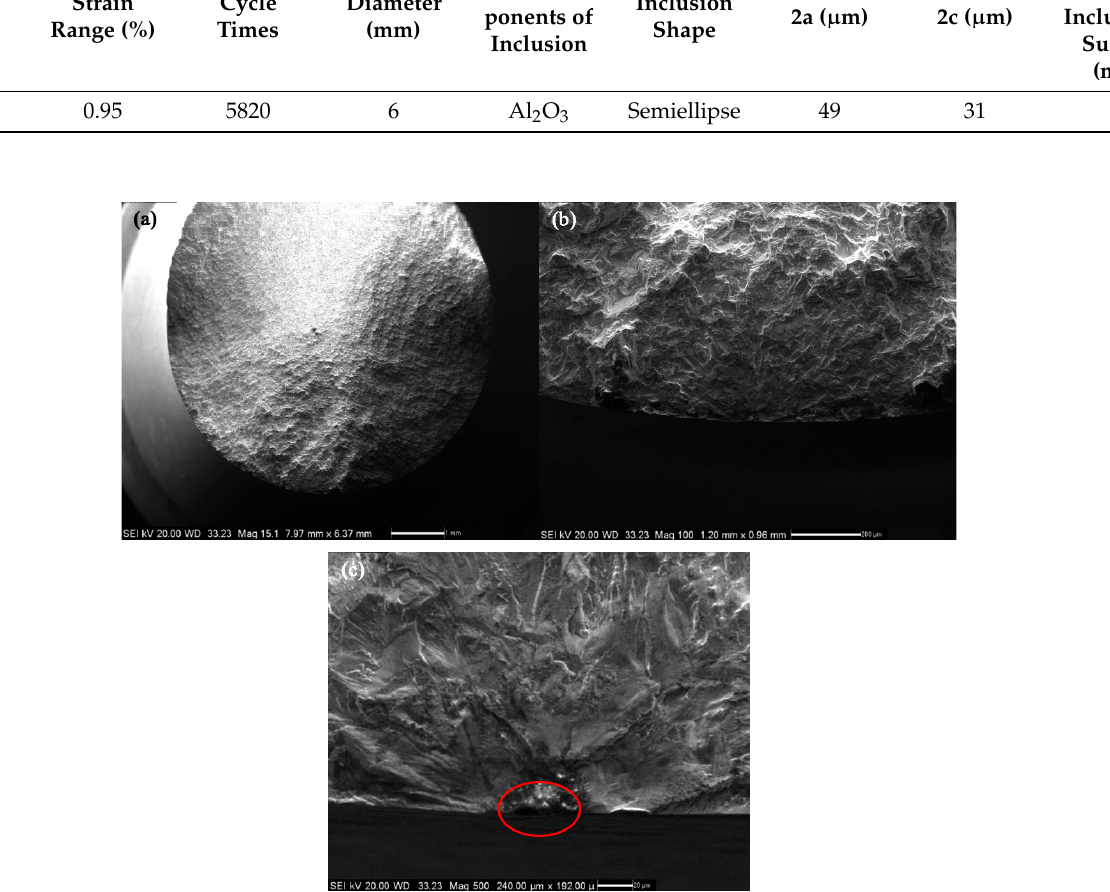
Figure 6. Morphology of fracture zone of specimen No. 2: ( a ) Macrofracture morphology, ( b ) crack source area and crack propagation region, ( c ) crack source area.